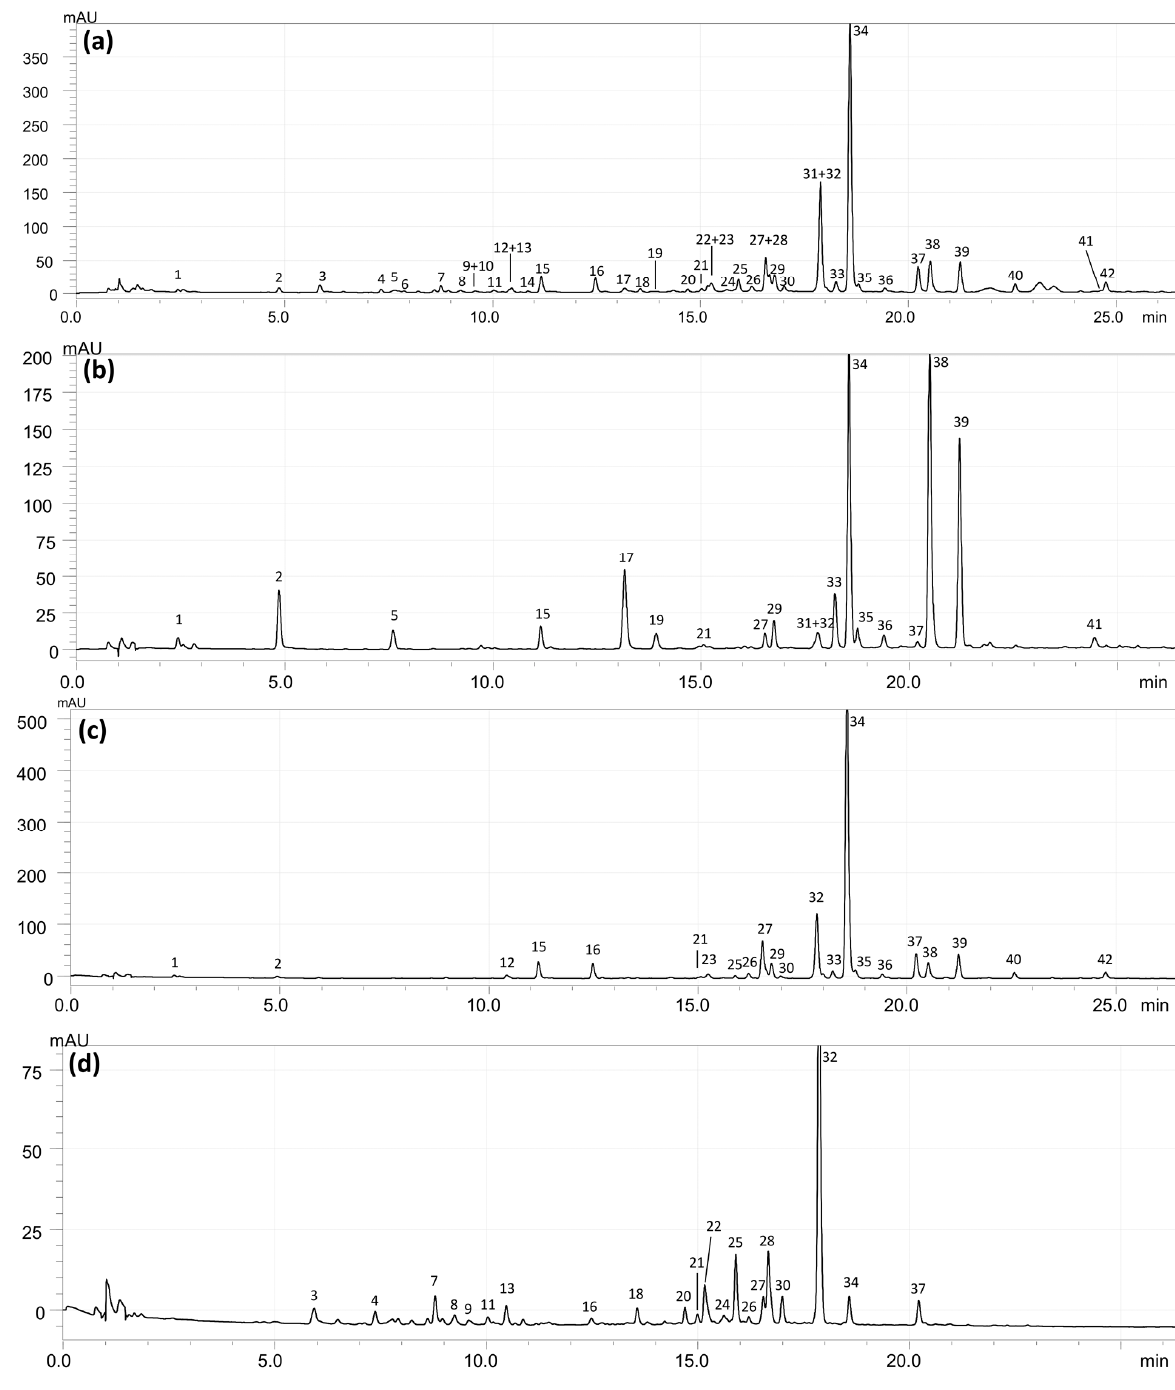
Figure 1. Representative UHPLC chromatograms of the investigated dry extracts from A. hippocastanum flower, λ = 280 nm. ( a ) ME, methanol extract; ( b ) DEF, diethyl ether fraction; ( c ) EAF, ethyl acetate fraction; ( d ) BF, n -butanol fraction. Peak numbering according to Table 1.